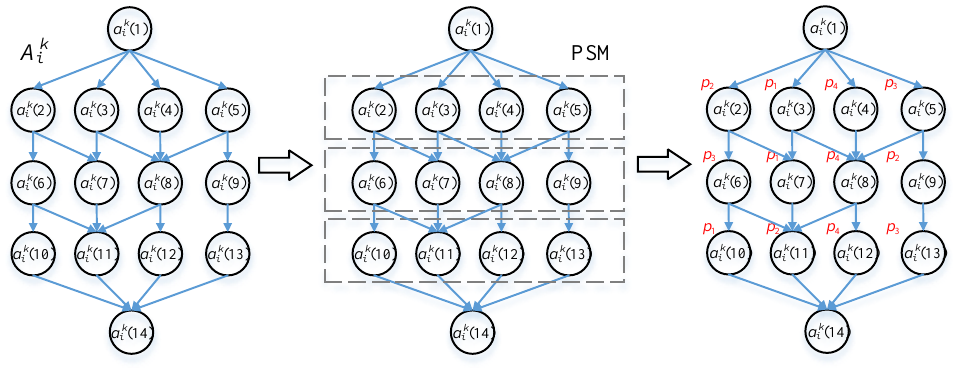
Figure 3. An illustration of PSM for the